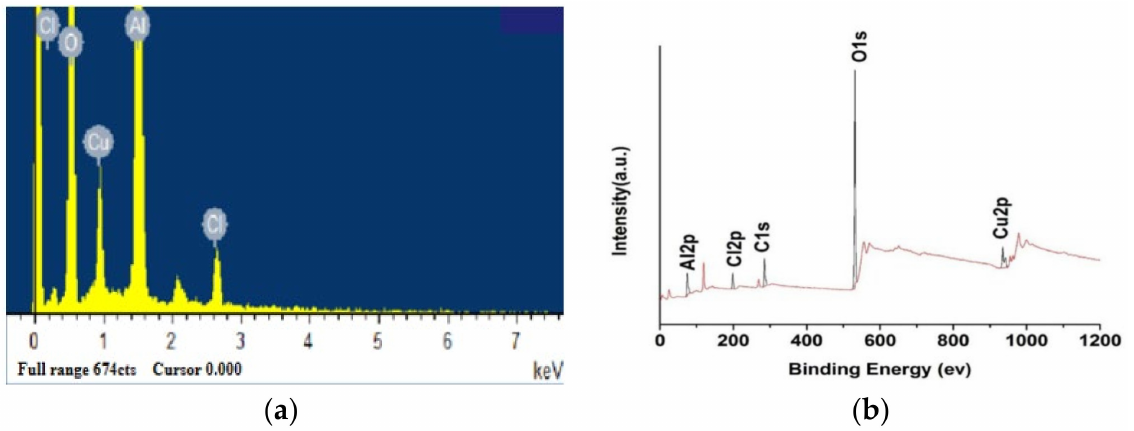
Figure 2. Elemental composition of nano-PAA-CuCl 2 , spectrum of EDS ( a ) and XPS ( b )